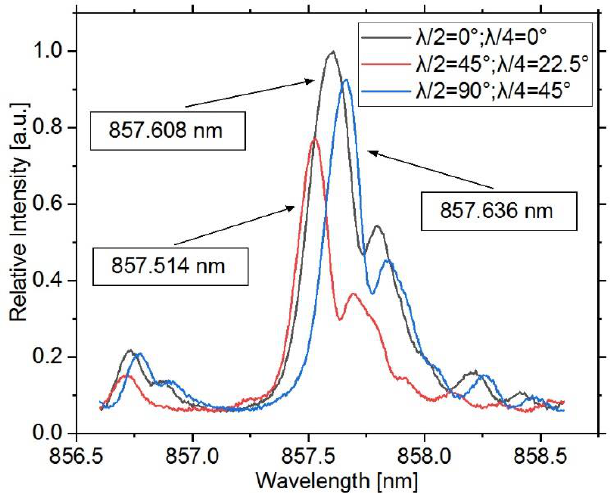
Figure 4. Reflection spectra for the two polarization states, which show the maximum wavelength difference of the main peak. The centers were calculated using Gauss fitting algorithms and differ by 122 pm. Additionally, the spectrum for the linear polarized starting condition is shown.